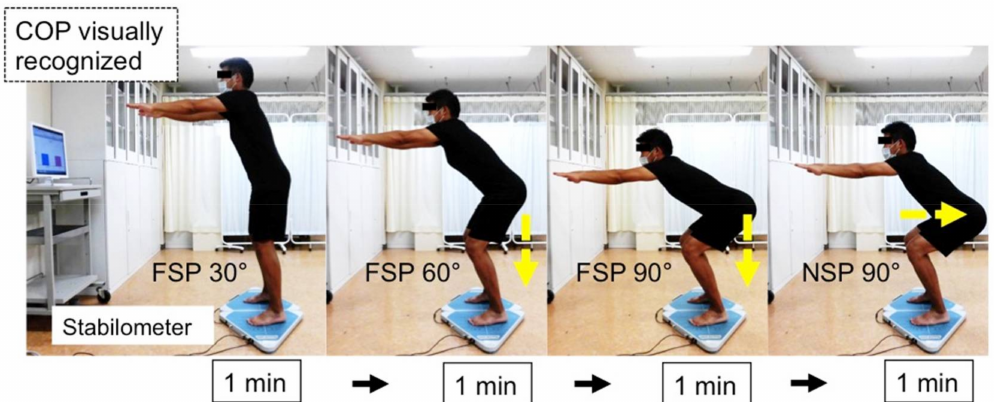
Figure 3. Representative scheme of training task A-1. Participants control the posture by monitoring by a stabilometer. Knee flexion is assisted by an assistant using a goniometer. The participants hold the posture for 1 min and switch to the next posture afterwards. Muscle activities of lower limbs are recorded and